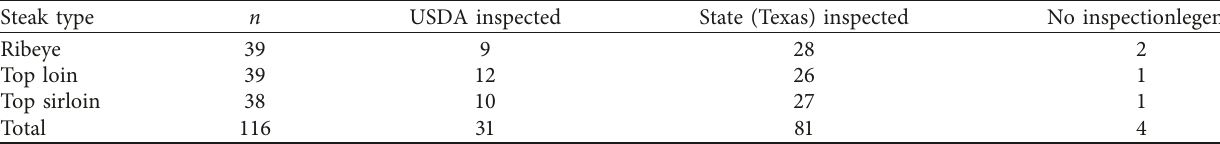
Table 10: Inspection for Farmers Market